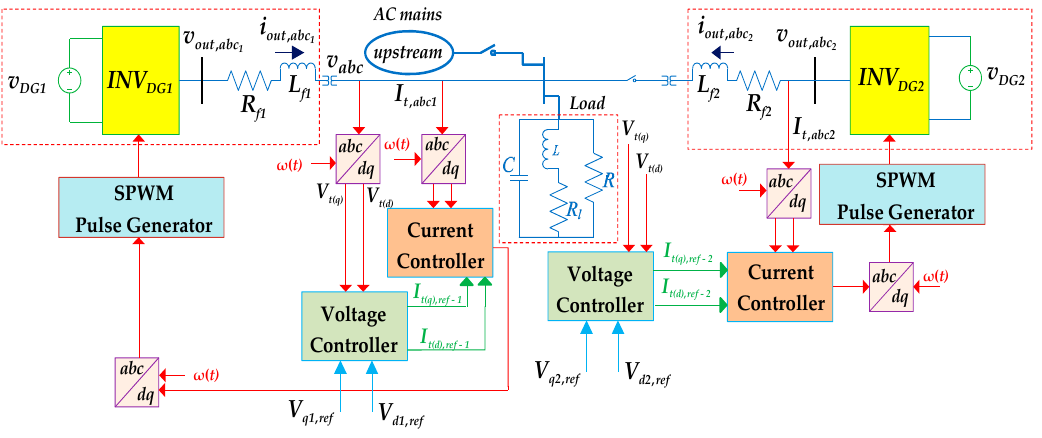
Figure 4. Two parallel-DG plants equivalent circuit in islanding operation.